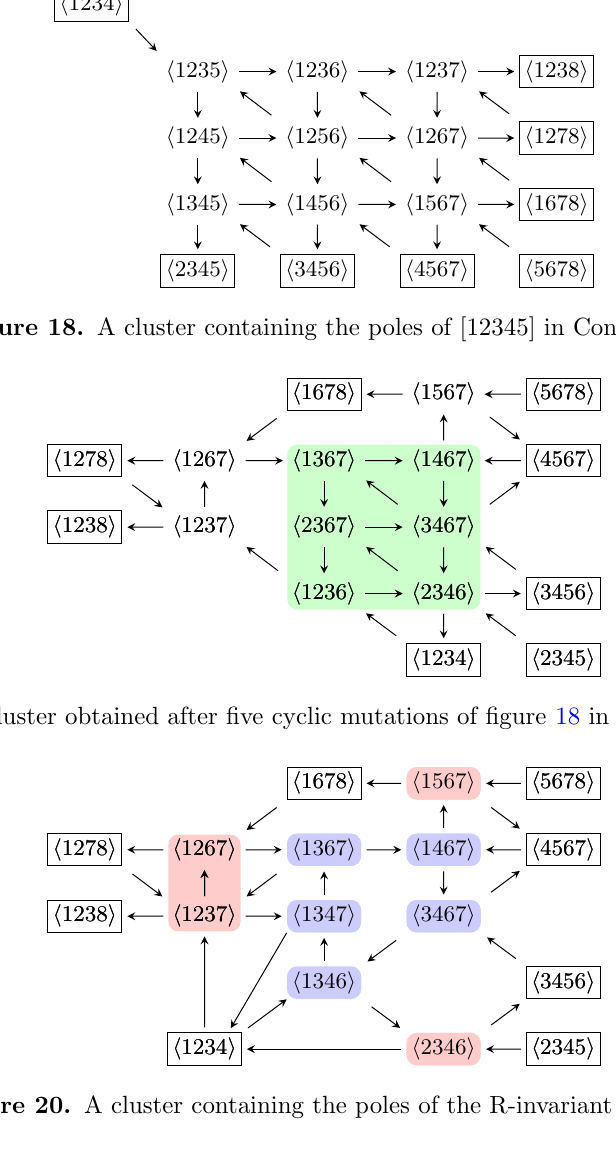
Figure 20. A cluster containing the poles of the R-invariant